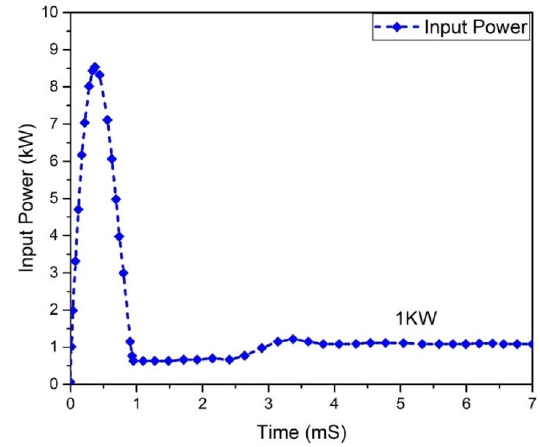
Figure 10. Input power analysis of Flyback boost converter.